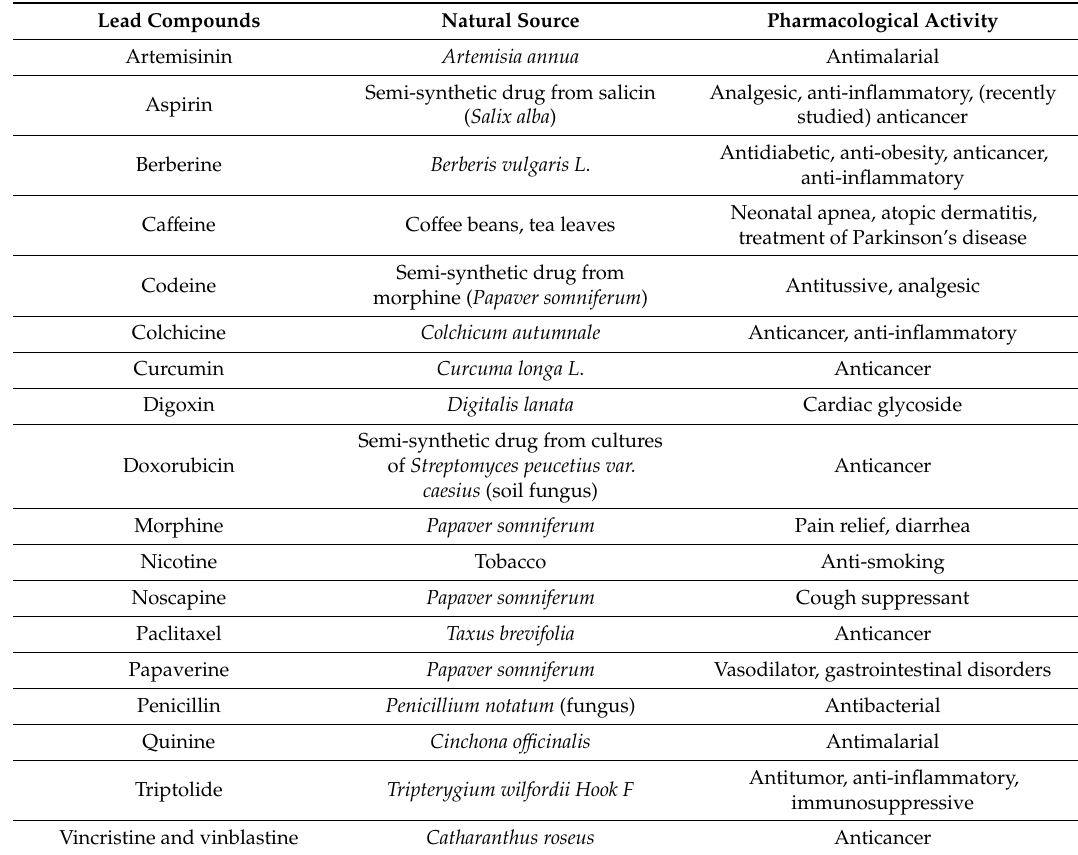
Table 1. Important lead compounds originating naturally subjected to the drug development process and